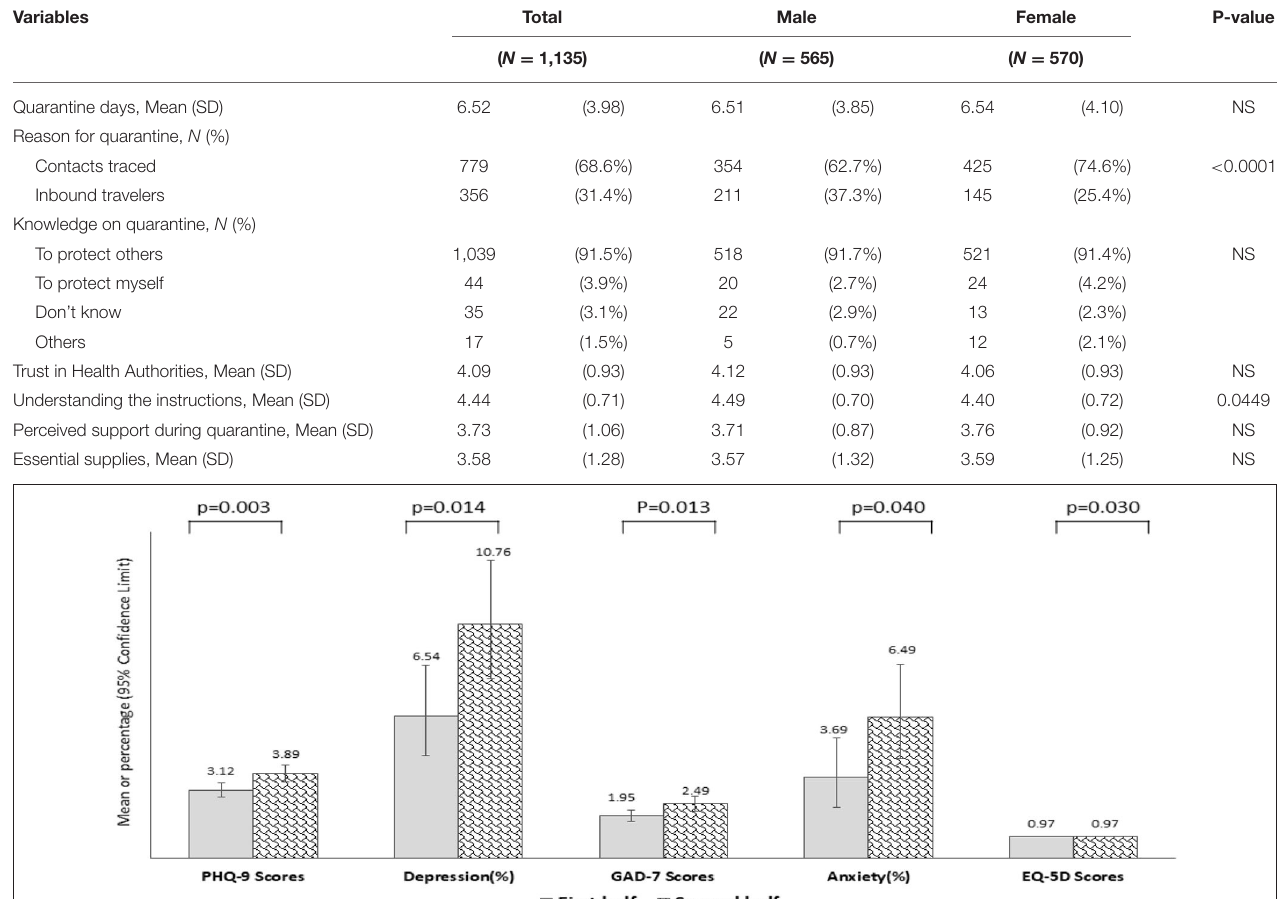
TABLE 2 | Characteristics of quarantine (Frequency & 5-point Likert scale). Variables